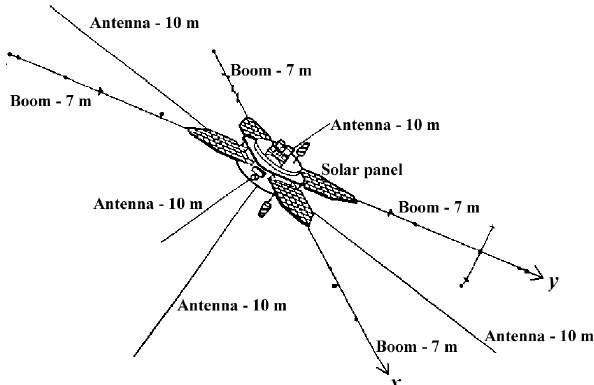
Fig. 1. Geometric structure of the Interball-2 satellite. The main body is a cylinder (radius 0.75m, height 1.60m) along the z -axis. Four flat solar panels looking like petals, are located in the x − y plane with extended booms at the end of each panel. Four other antennas (length 10m) are located in a plane parallel to the x − y plane. A monopole (length 10m) is inclined at 5 ◦ to the z -axis. The spacecraft spins around the z -axis, which is sunward directed. Therefore, the sunlit parts of the spacecraft are the surfaces perpen- dicular to the z -axis, i.e. the four solar panels and the top cylindrical